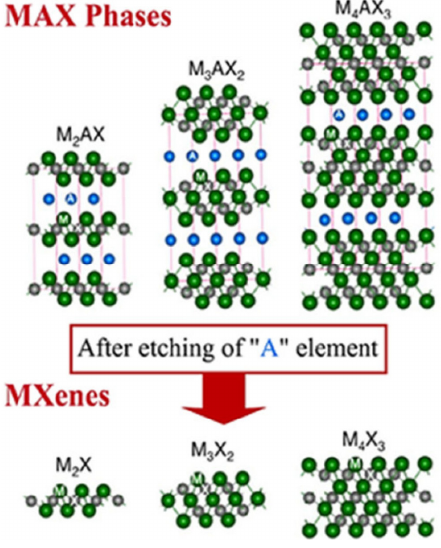
Figure 4. Etching of the MAX phase and creation of SMQDs with surface groups. (Reprinted with permission [99] Copyright © 2021 by the authors. Licensee MDPI, Basel, Switzerland.)